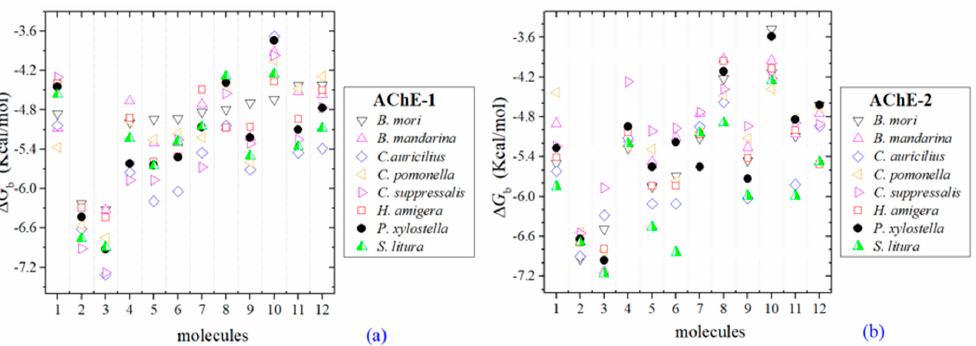
Figure 3. Predicted Δ G b results of the low inhibition score of OPs molecules in AChE-1 ( a ) and AChE- 2 ( b ), both wild type. Δ G b , estimated free energy of binding; molecules: 1, acetylcholine; 2, psoralen; 3, chlorpyrifos-methyl; 4, disulfoton; 5, dicrotophos; 6, naled; 7, dimethoate; 8, trichlorfon; 9, mevinphos; 10, methamidophos; 11, dichlorvos; and 12,